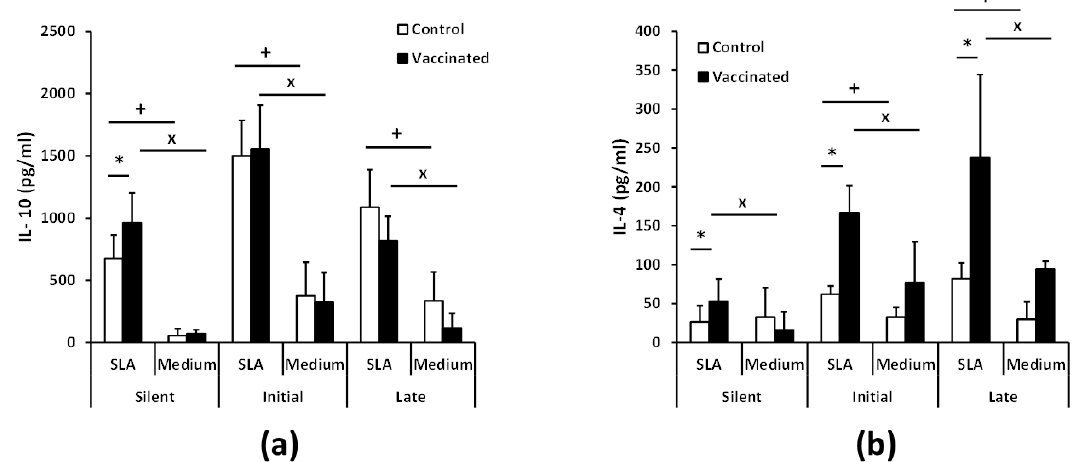
Figure 5. Parasite-specific IL-10 and IL-4 production. BALB/c mice ( n = 8 per group) were vaccinated and infected as in Figure 4. Spleen cell cultures from each mouse were independently established in the silent, initial, and late phases and stimulated for 72 h with soluble SLA or cultured without stimulus (medium). IL-10 ( a ) or IL-4 ( b ) levels were measured in culture supernatants by quantitative sandwich ELISA. Data are represented as the mean (+ SD) and statistics were analyzed by a Student T test. * ( p < 0.05) shows the statistical differences between control and vaccinated mice. + ( p < 0.05) shows the statistical differences between SLA-stimulated and unstimulated cytokine production in the control group. × ( p < 0.05) shows the statistical differences between SLA-stimulated and unstimulated levels in the vaccinated group. Results are representative of two independent experiments.